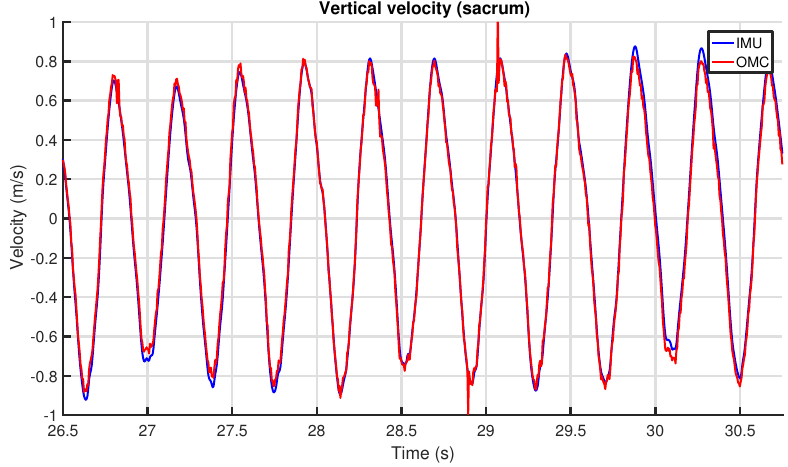
Figure 17. Example of the vertical velocity match between IMU and OMC systems for the sacrum.